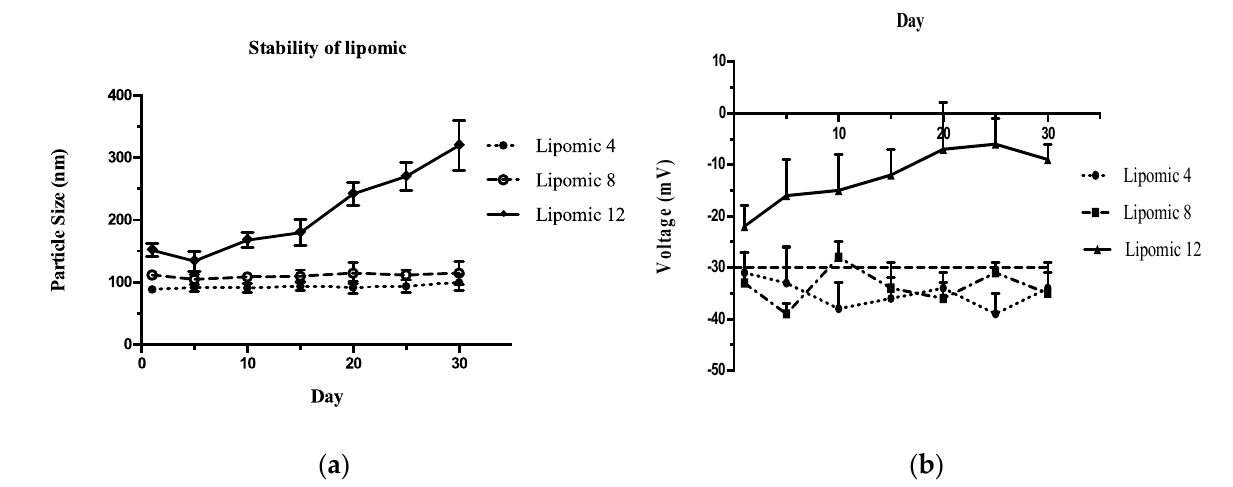
Figure 2. The evaluation of particle size and Z potential for one month, shown for formulations 4, 8, and 12. ( a ) The variations in particle size and ( b ) Z potential.